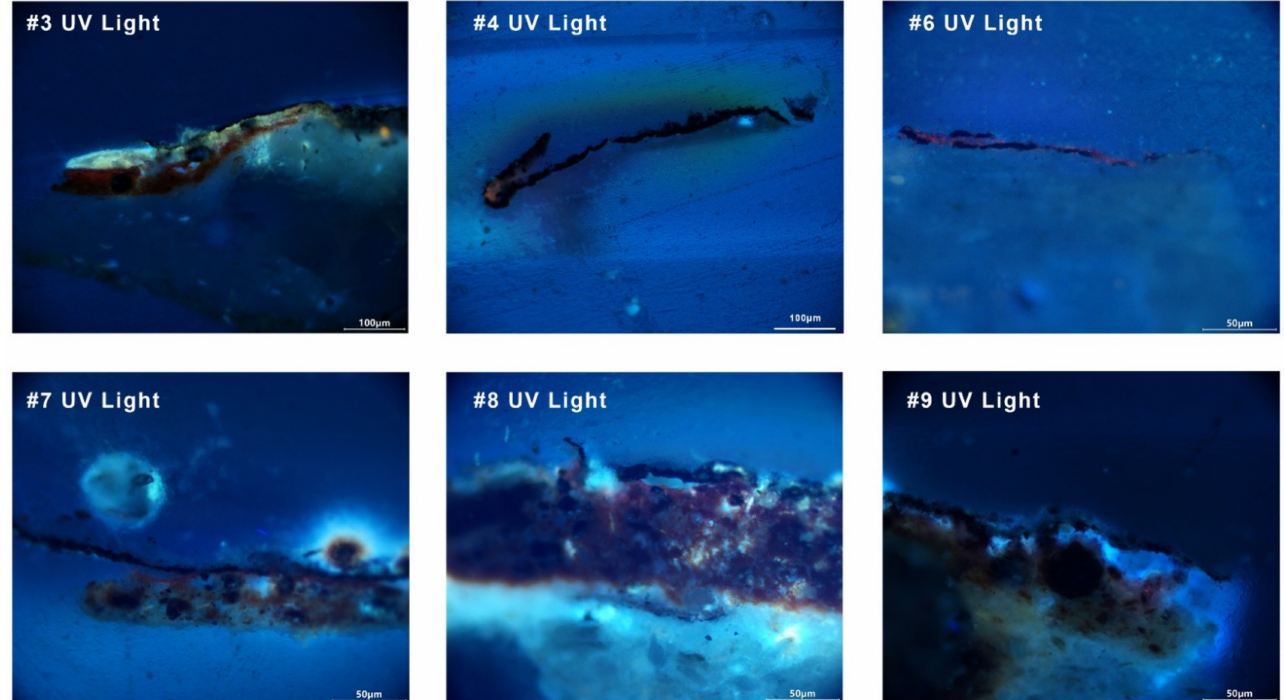
Figure 5. Sample with orange-red fluorescence emission observed under